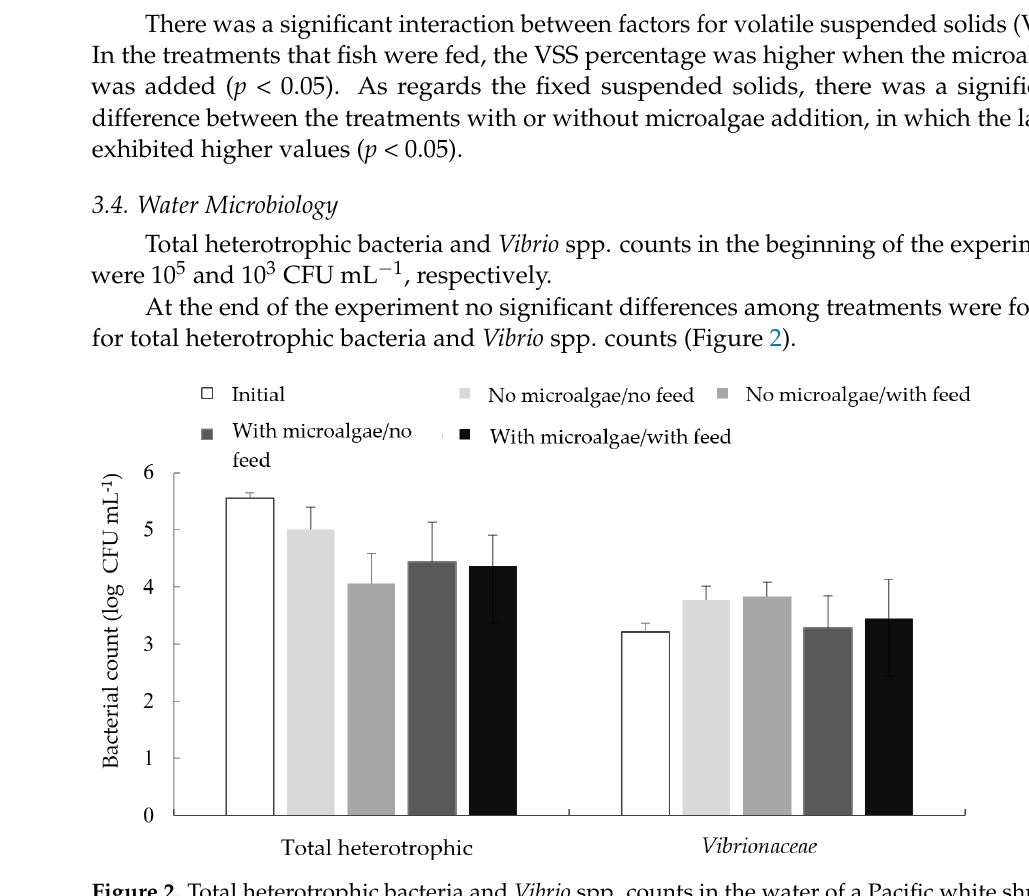
Data presented as mean ± standard deviation. * Indicates significant differences by two-factor ANOVA ( p < 0.05), with fish feed (ff) and microalgae (m) as factors and their interaction expressed as ff × m. 1 Significant difference when considering only the effect of microalgae addition. FSS (%) of tanks with no microalgae addition (52.8 ± 3.5) and with microalgae addition (51.5 ± 2.5). Different letters between means indicate significant differences according to Tukey’s test ( p < 0.05). TSS: total